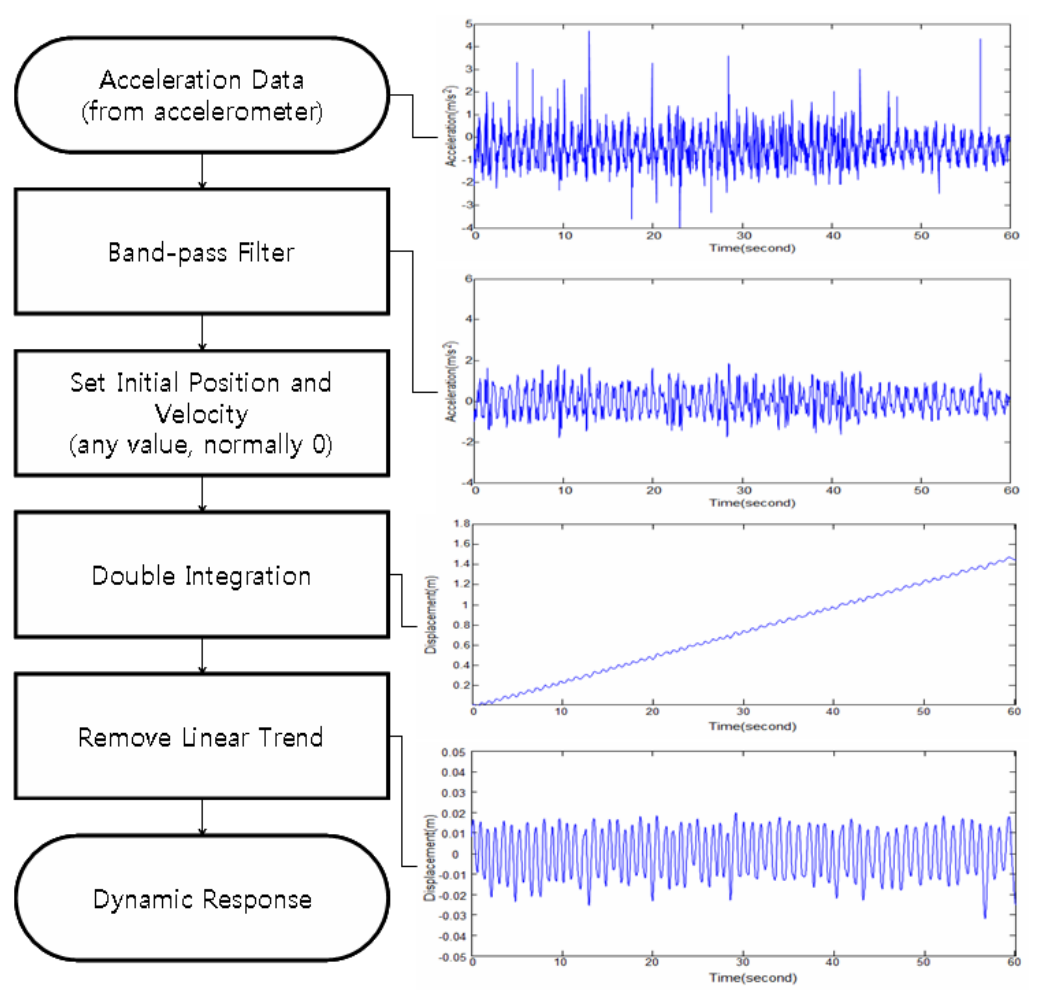
Figure 1. Calculation of the dynamic displacement using the acceleration